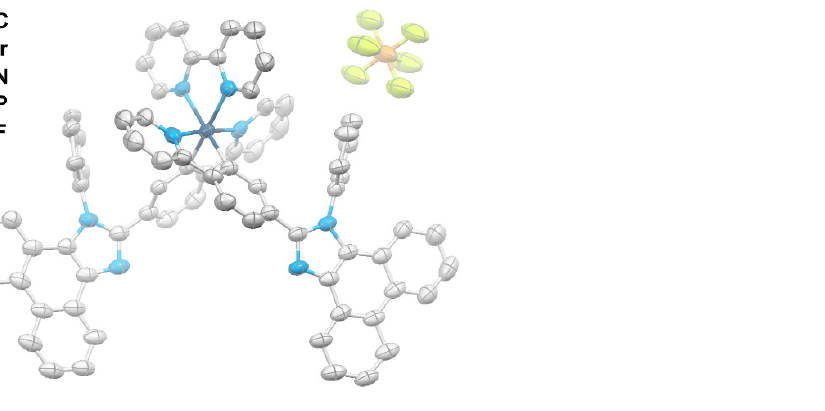
Table 1. Photophysical properties of complexes 1 and 2 , and ligand precursor N^CH in CH 2 Cl 2 , complex 3 in methanol, and complex 4 in aqueous solutions, 298K.